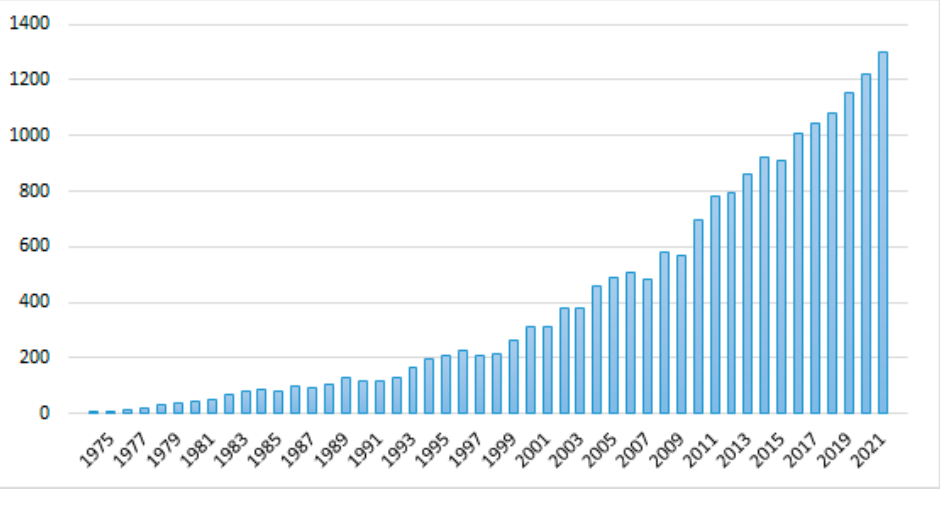
Figure 3. Evolution of the number of publications on (nano)liposomes and cancer.